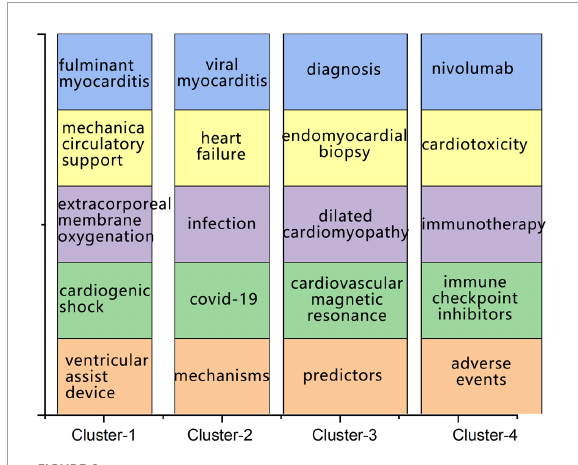
FIGURE6 The top five representative keywords of each cluster.